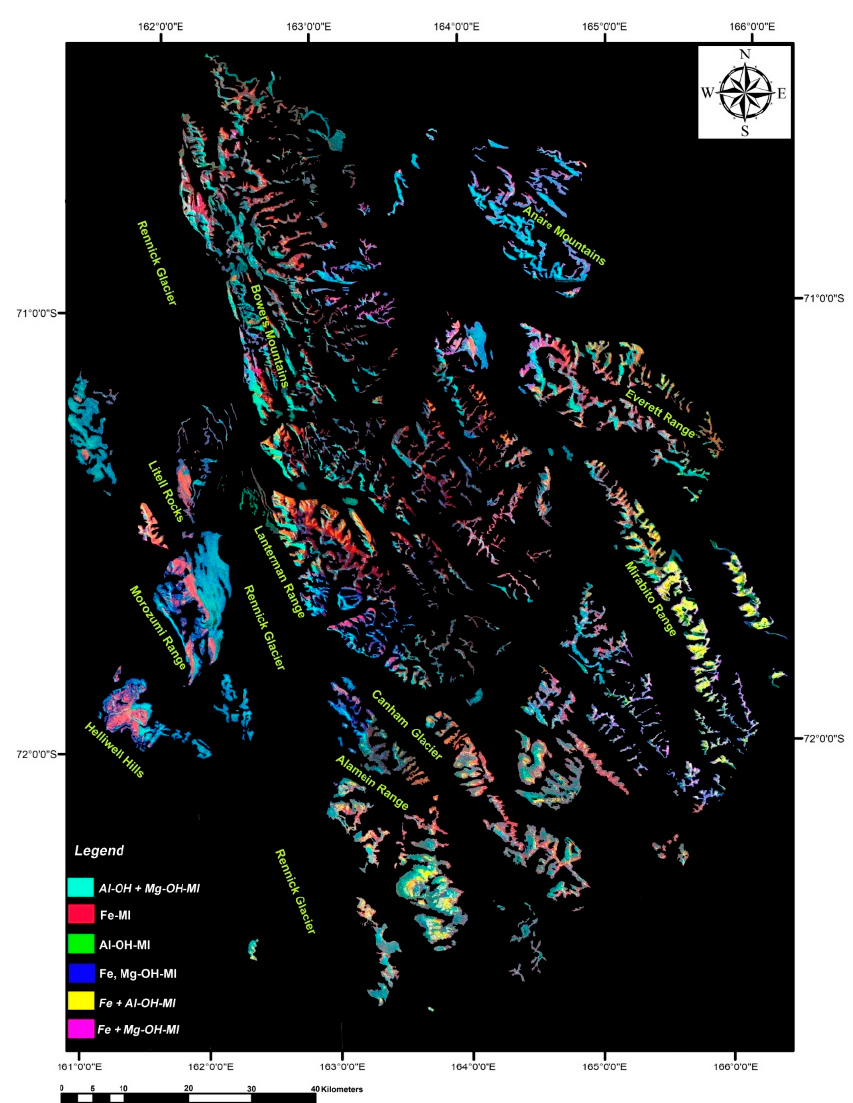
Figure 6. ASTER mosaic image of Fe-MI, Al-OH-MI and Fe,Mg-OH-MI as RGB color composite. It shows exposed lithologies in the Bowers Terrane (BT) and surrounding areas. The locations of some large mountain ranges are shown.